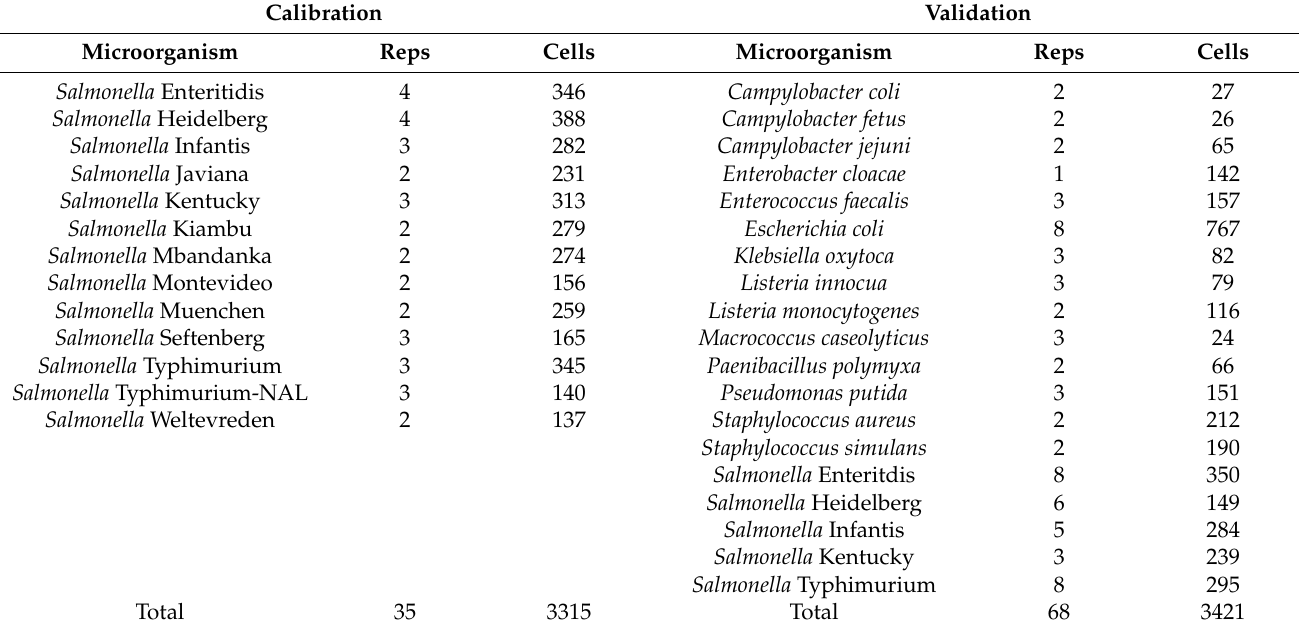
Table 2. List of spectral library files used in building and validating the soft independent modeling of class analogy (SIMCA) from hyperspectral microscope images of bacterial